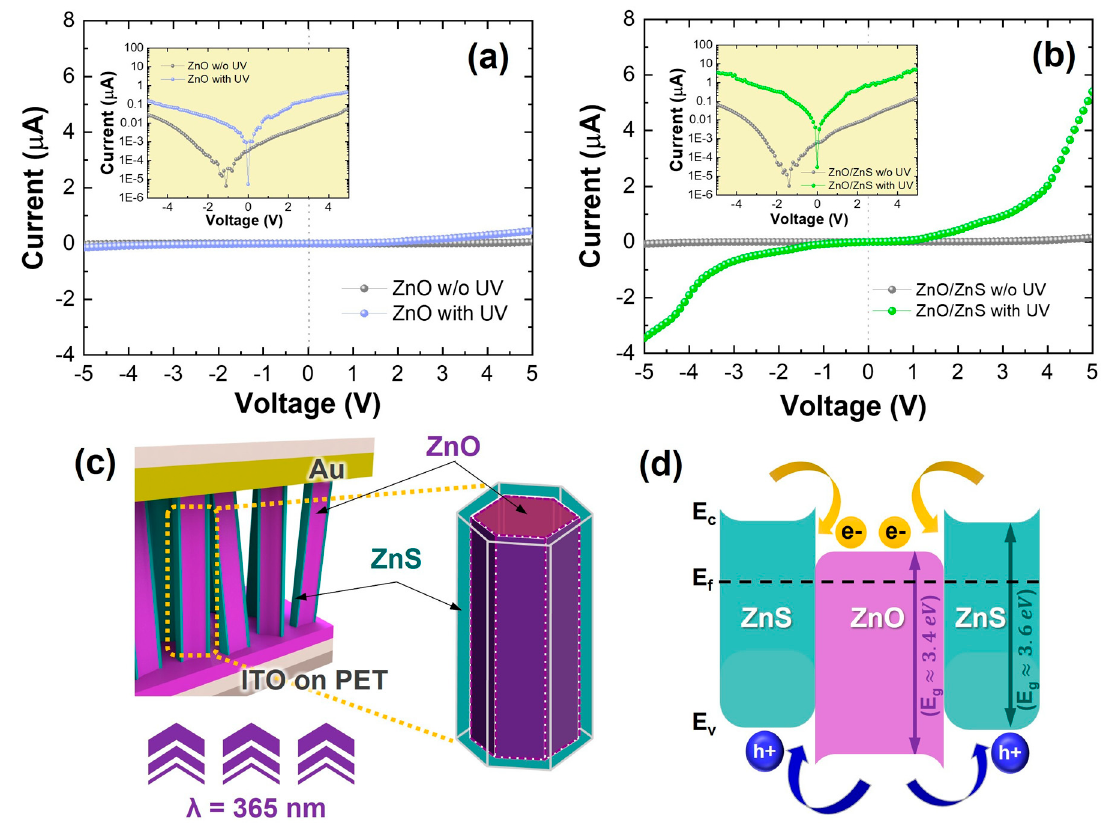
Figure 3. Current–voltage ( I – V ) characteristics of ( a ) ZnO NWs and ( b ) ZnO/ZnS core/shell NW arrays in dark condition and under 365 nm UV illumination (0.78 mW/cm 2 ). Inset: ln I – V curves in the dark and under UV illumination. ( c ) Schematic of cross-sectional view of ZnO/ZnS core/shell NW devices with illumination source of 365 nm UV light and ( d ) its corresponding type-II energy- band diagram.